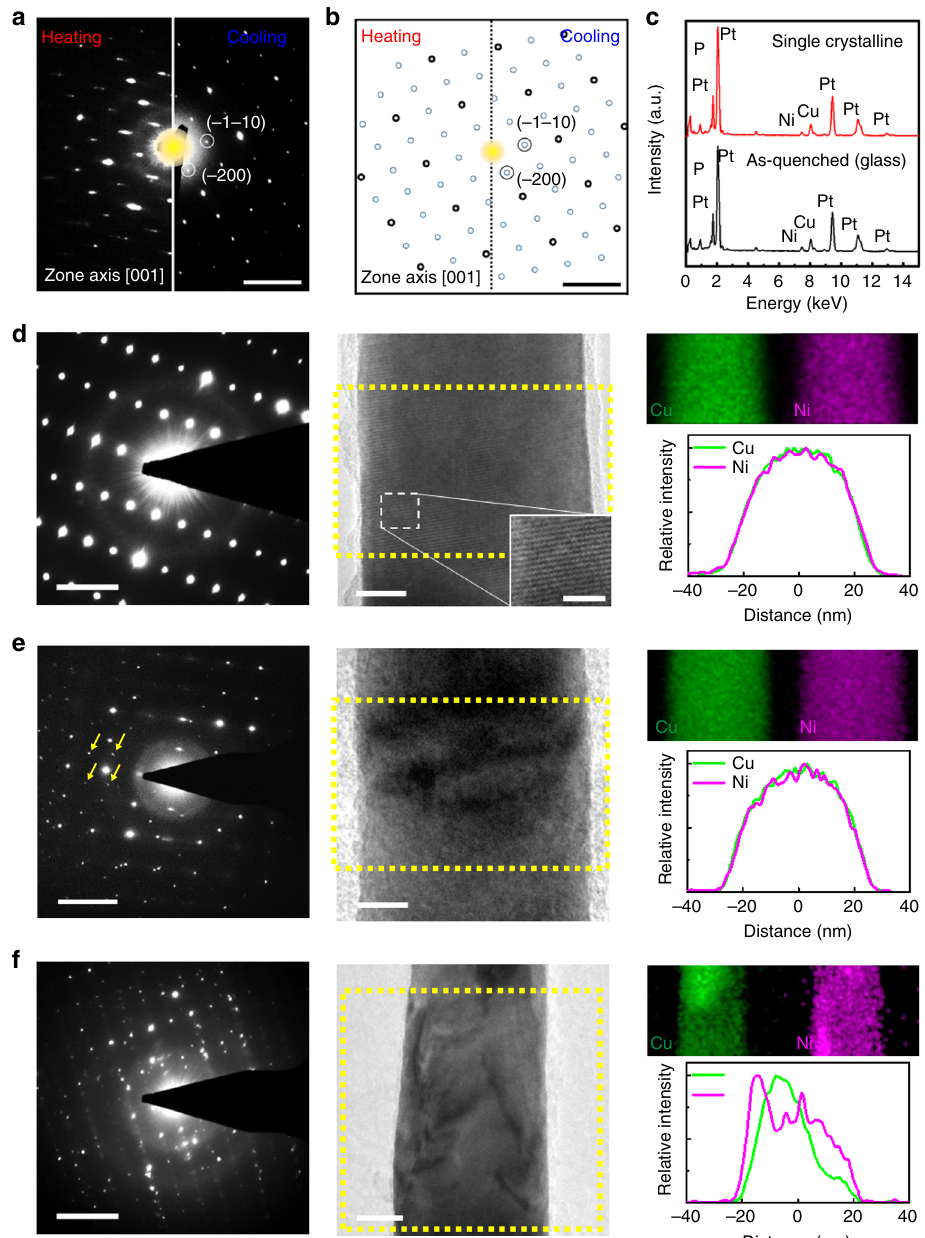
Fig. 3 Multiple crystallization phases as a function of the cooling rate and the metallic glass nanorod diameter. a , b Characterization of the apparent single crystalline phase upon heating and cooling of the MG nanorods. a SAED patterns obtained during heating (100 °Cs − 1 ) (left half of a) and cooling (50 °Cs − 1 ) (right half of a ) of a 40 nm nanorod. Both patterns, identical to each other, show a [001] zone axis of a monoclinic C2/c-like structure. Detailed crystal structure discussion in Supplementary Note 3. b Schematic representation of the SAED pattern, indicating the same crystalline product during the heating and cooling. c EDX spectra from the apparent single crystalline phase and the glass phase of the nanorod. The spectra show negligible differences, suggesting identical chemical composition for the single crystalline and the glass phase. d An apparent single crystalline phase in a 45 nm nanorod cooled at a higher cooling rate (100 °Cs − 1 ). The single crystallinity is con fi rmed by the SAED pattern (left panel of d ) and lattice fringes in the TEM image (middle panel of d ), scale bar = 10, 2 nm in inset). Its chemical composition appears identical to the glass composition with the Ni and Cu homogeneously distributed (right panel of d ). e A polycrystalline grain in a 45 nm nanorod cooled at a lower cooling rate (5 °Cs − 1 ). The SAED pattern shows a polycrystalline nature with extra diffraction spots pointed by yellow arrows (left panel of e ). The bright and dark contrast change in the TEM image (middle panel of e , scale bar = 40 nm) suggests a relative orientation difference of the grains. Its chemical composition appears identical to the glass composition with the Ni and Cu homogeneously distributed (right panel of e ). f A polycrystalline grain in a 80 nm nanorod cooled at a lower cooling rate (5 °Cs − 1 ). The SAED pattern shows crystalline grains with various orientations (left panel of f) . Scale bar = 25 nm in the middle panel of f . The chemical compositions of the polycrystalline grains are different from the glass composition, as evident by the Cu-rich and Ni-rich regions (right panel of f ). All scale bars in SAEDs are 4 nm −